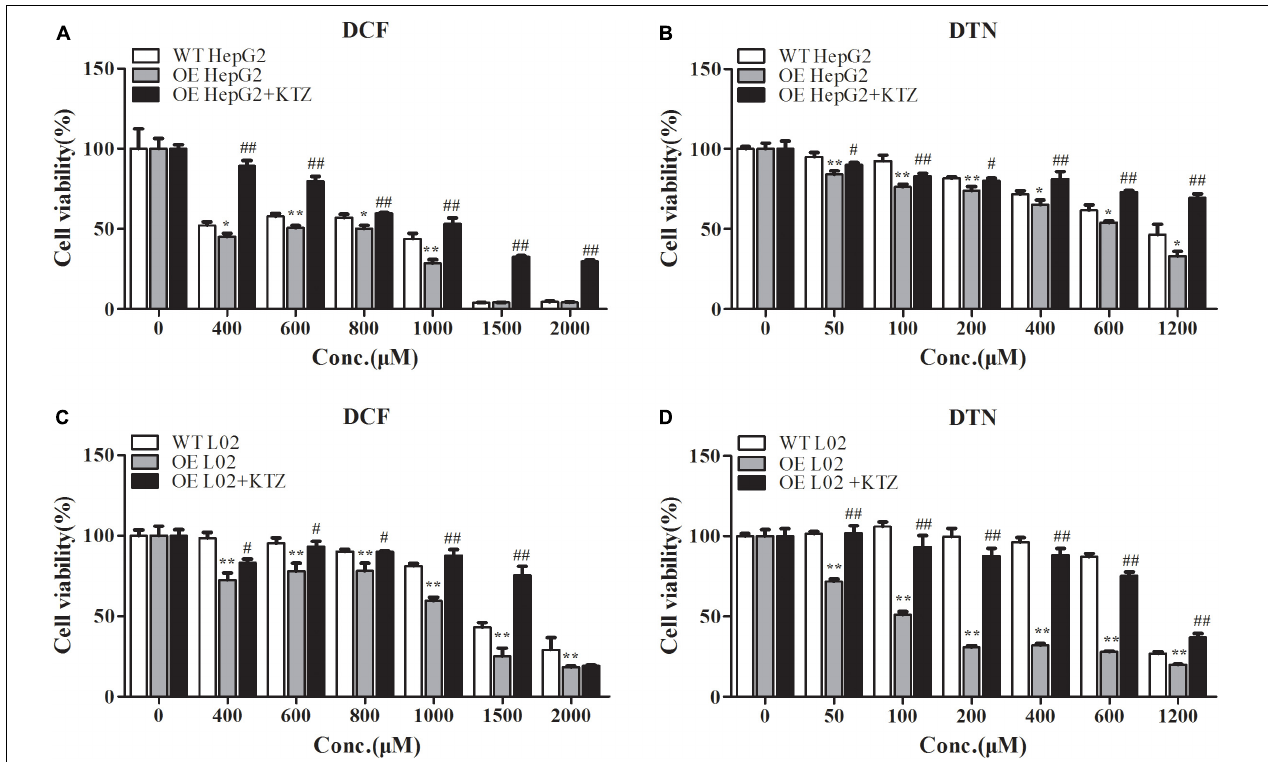
FIGURE 7 | The effect of over-expression and inhibition of CYP3A4 on the cytotoxicity of DCF and DTN in HepG2 and L02 cells. (A,B) Over-expression and inhibition of CYP3A4 on the cytotoxicity of DCF and DTN in WT and OE HepG2 cells. (C,D) Over-expression and inhibition of CYP3A4 on the cytotoxicity of DCF and DTN in WT and OE L02 cells. Data are represented as mean ± SD ( n = 3). ∗ p < 0.05, ∗∗ p < 0.01 vs. WT groups; # p < 0.05, ## p < 0.01 OE+KTZ groups vs. OE